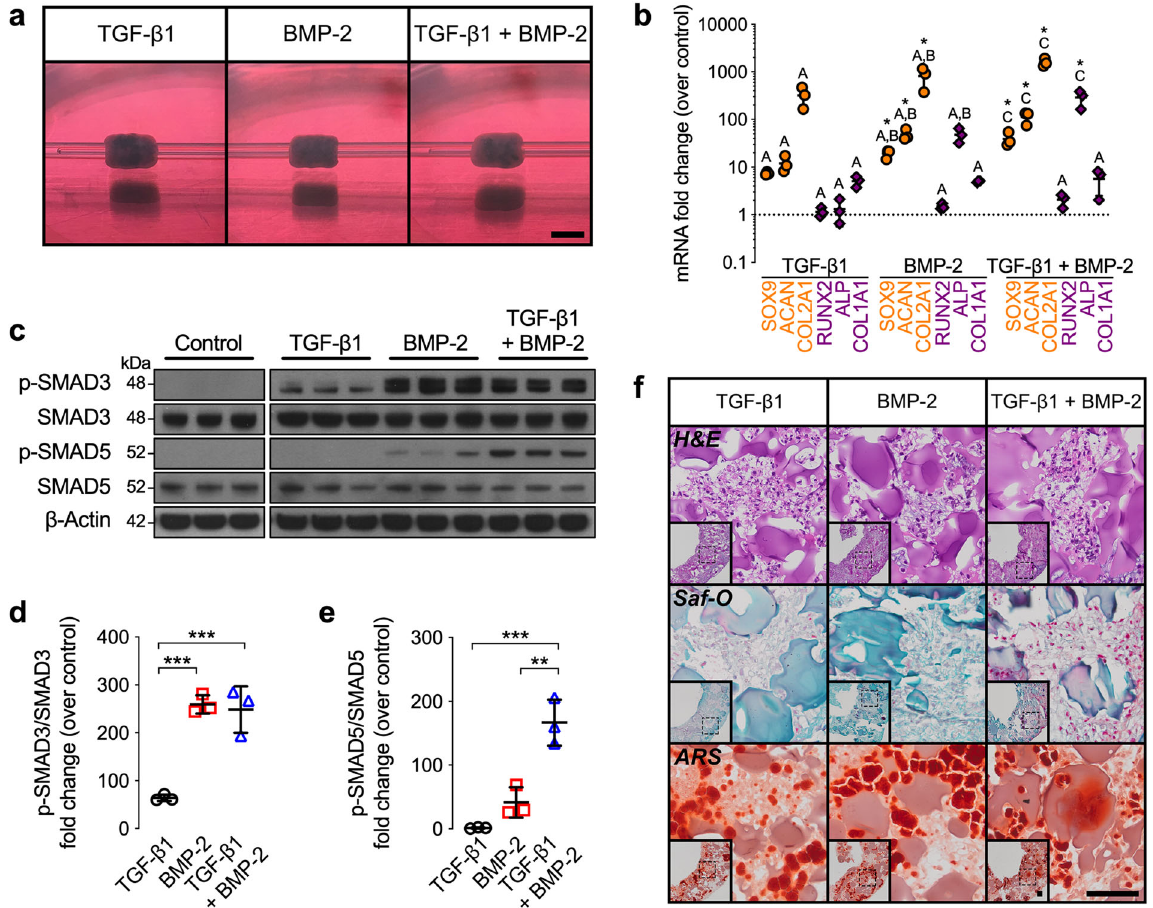
Fig. 2 In vitro macroscopic, biochemical, molecular, and histological evaluation of engineered hMSC condensate tube early chondrogenic priming. a Representative gross macroscopic images of hMSC tubes containing TGF- β 1-loaded, BMP-2-loaded, or TGF- β 1 + BMP-2-loaded microparticles at day 8. Scale bar, 4 mm. b Normalized mRNA fold-change over control of key chondrogenic and osteogenic markers by qRT-PCR ( n = 3 biologically independent samples per group; * p < 0.05 vs. control; orange circles = chondrogenic markers; purple diamonds = osteogenic markers). c Immunoblots and d relative fold-change over control of p-SMAD3/SMAD3, and e p-SMAD5/SMAD5. β -Actin served as a loading control ( n = 3 biologically independent samples per group; ** p < 0.01, *** p < 0.001; black circles = TGF- β 1; red squares = BMP-2; blue triangles = TGF- β 1 + BMP-2). f Representative histological Hematoxylin & Eosin (H&E), Safranin-O/Fast-green (Saf-O), and Alizarin Red S (ARS) staining of transaxial hMSC tube sections. Scale bars, 100 μ m (dotted squares in insets show region of interest in high magni fi cation image). Individual data points are shown with mean ± SD. Groups with shared letters have no signi fi cant differences. Analyzed by one-way ANOVA with Tukey ’ s post hoc test ( p < 0.05 or lower considered signi fi